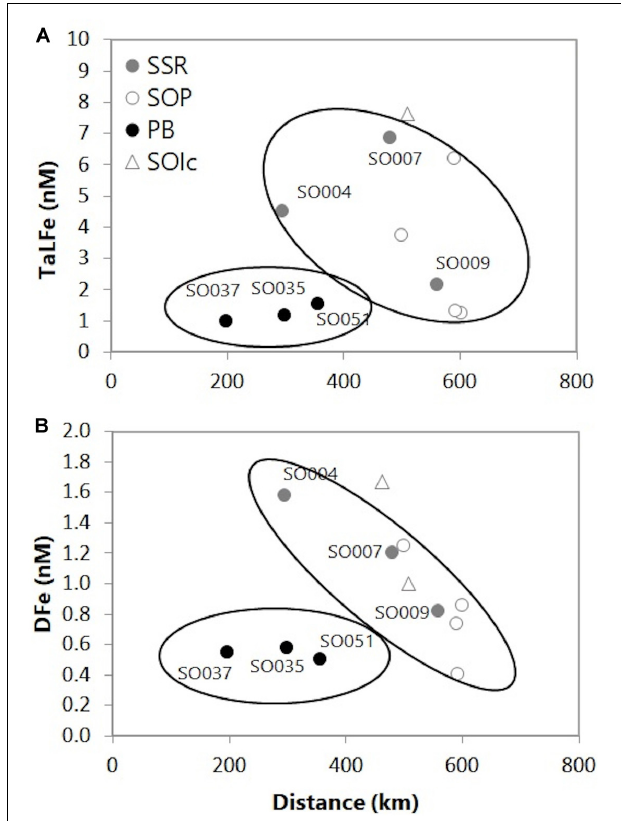
FIGURE 8 | (A) Average TaLFe (nM) and (B) DFe (nM) for the upper water column (225 m) for the stations in the SOI, in relation to the distance to Antarctic Peninsula (based on 54.5 ◦ W). SSR: South Scotia Ridge, SOP: South Orkney Plateau, PB: Powell Basin, SOIc: South Orkney Islands